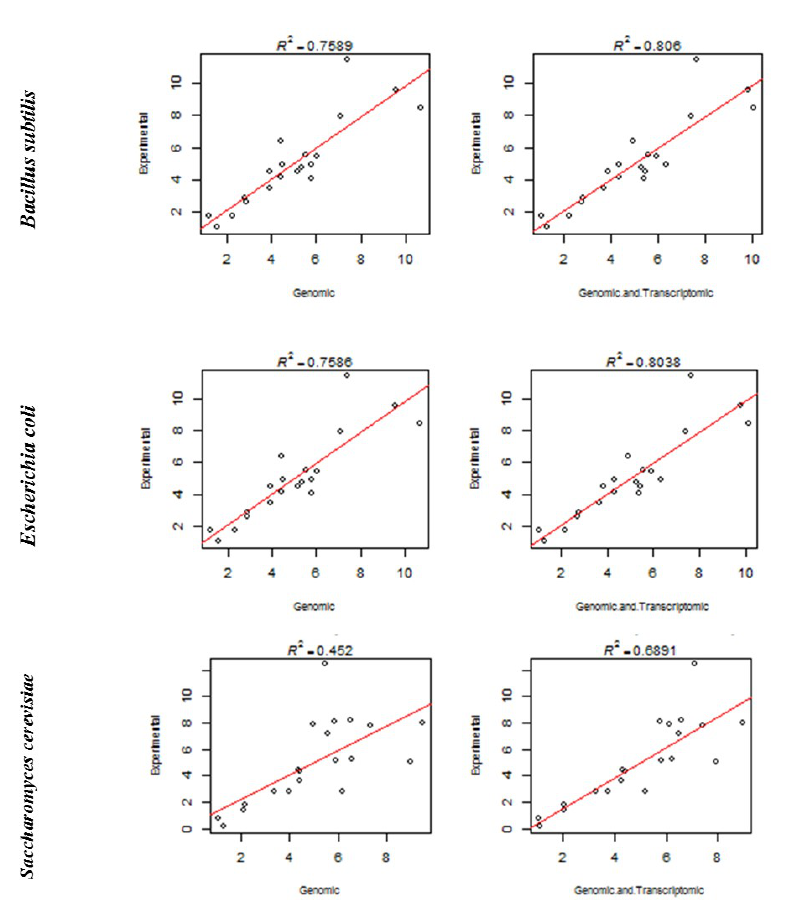
Figure 4: Comparison of the biomass composition in amino acids obtained using the java tool (either with only genome information or using genome and transcriptomic information) with ex- perimental data from the literature. Correlation between the data is represented by the R 2 . Amino acid composition is represented in molar